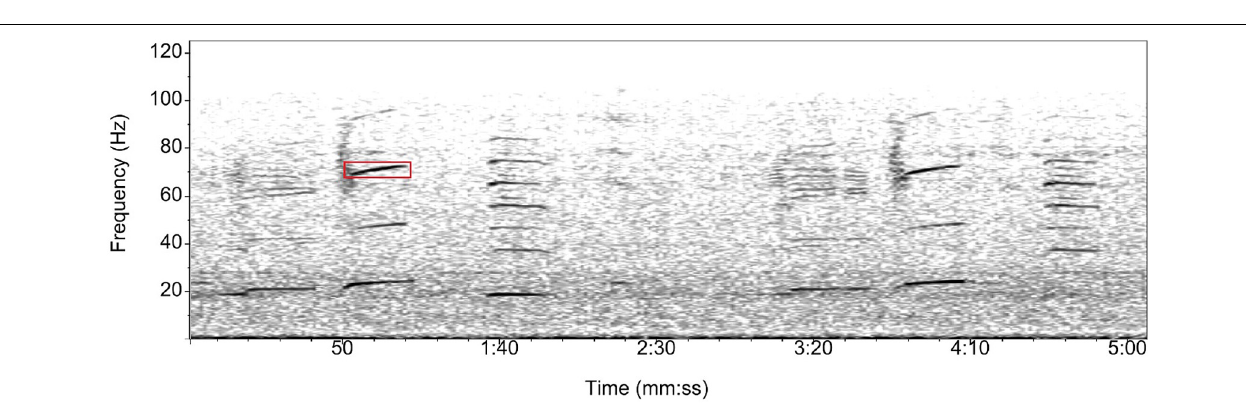
FIGURE 3 | Spectrogram of the Southeast Indian Ocean (SEIO) pygmy blue whale call. The red box shows the third harmonic of the second unit targeted by the automated spectrogram correlation detector in Ishmael. Spectrogram parameters: Hamming window, 1,024 points FFT length, 50% overlap.